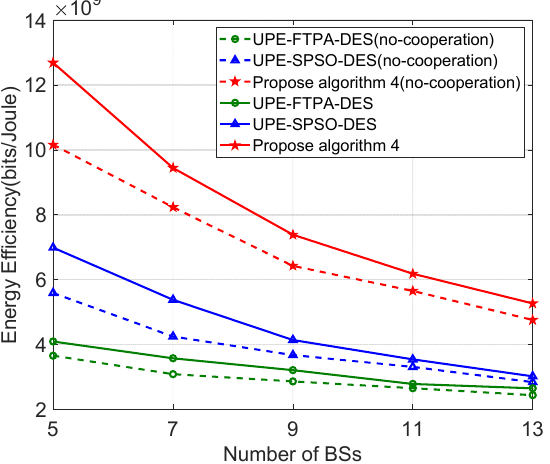
Figure 10. Energy efficiency versus the number of BSs for different joint algorithms.